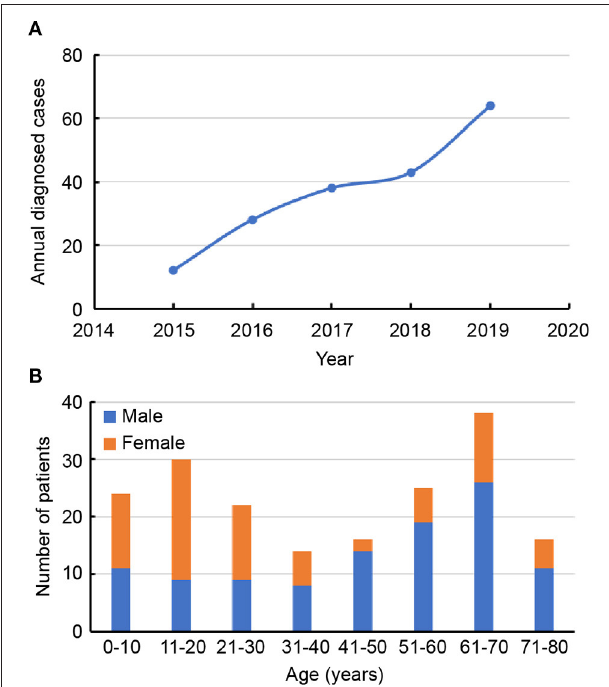
FIGURE 2 | (A) Trends in the numbers of annual diagnosed cases of autoimmune encephalitis. (B) Distribution of gender and age of patients with autoimmune encephalitis.